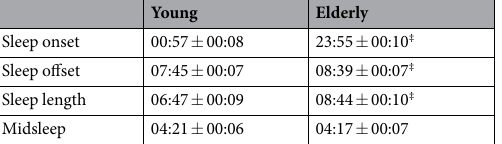
Table 3. Sleep parameters by age group (elderly participants, n = 44; young participants, n = 44). Values are expressed as the mean ± SEM (hh:mm). ‡ p < 0.001, according to the General Linear Model controlled by